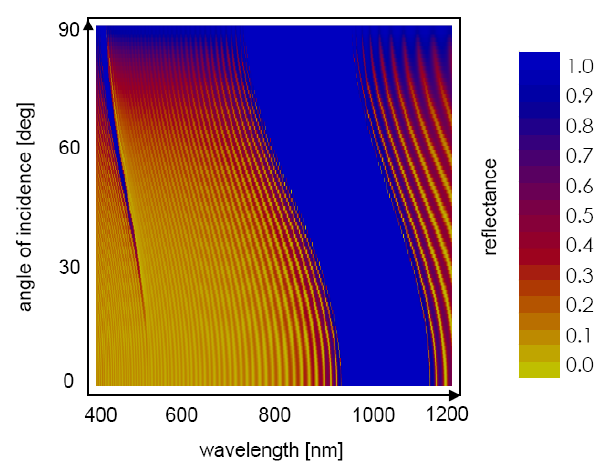
Figure 5. Angular dependent reflection characteristic of a Bragg stack. In the figure, the reflectance of a rugate filter is displayed in dependence of the wavelength and the angle of incidence. The reflection peak of the filter is situated around λ = 1,000 nm and shifts towards the blue for an increasing angle of